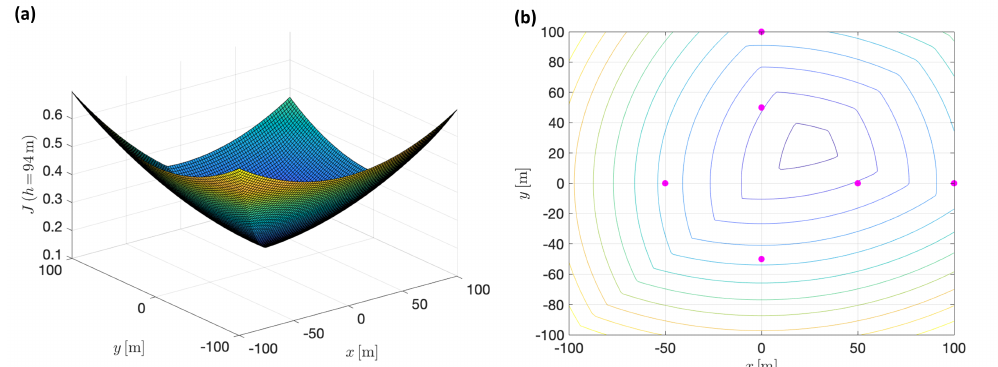
Figure 11. ( a ) Min–max surface example, corresponding to a particular altitude ( h = 94[m]), for a given non-symmetric six-target arrangement. ( b ) Corresponding level curves, where the magenta dots represent targets’